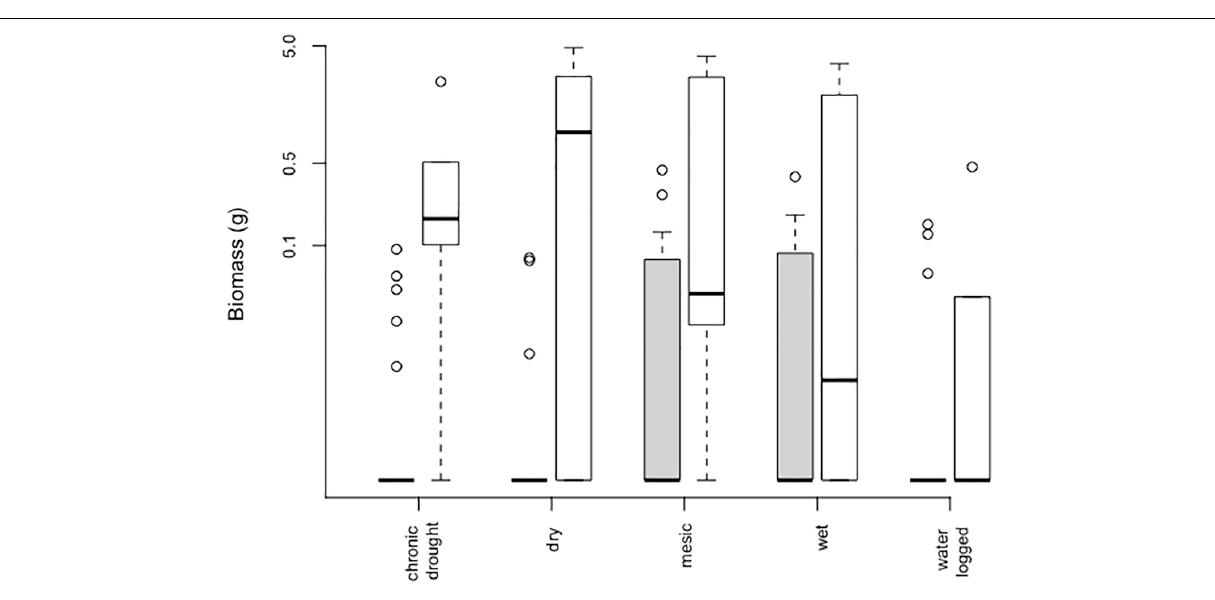
increased performance of B. orientalis